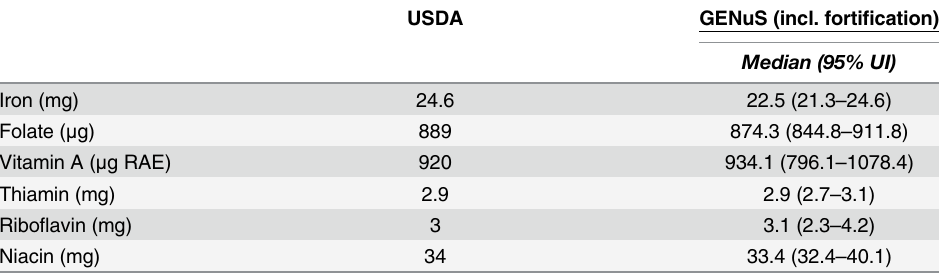
Table 3. GENuS-USDA Data Comparison for Fortified Nutrients. USDA [50] vs. full GENuS estimates of 2010 supplies of nutrients that are commonly